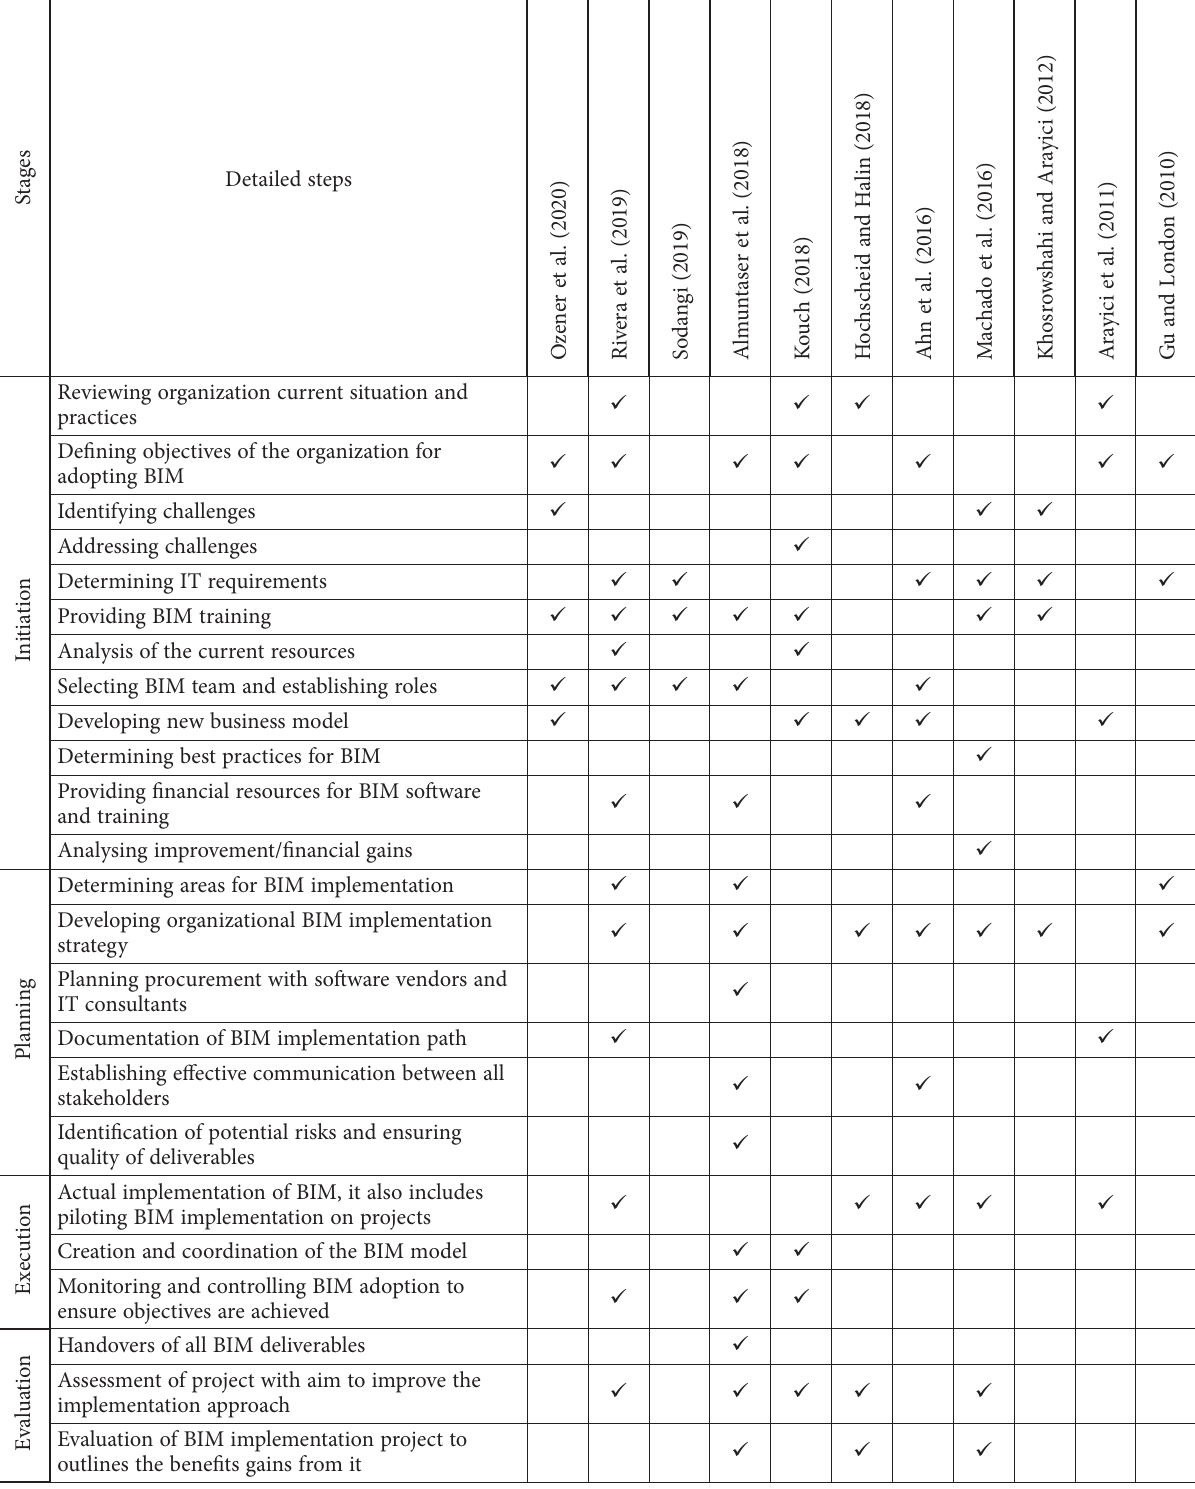
Table 2. AEC/FM industry BIM adoption